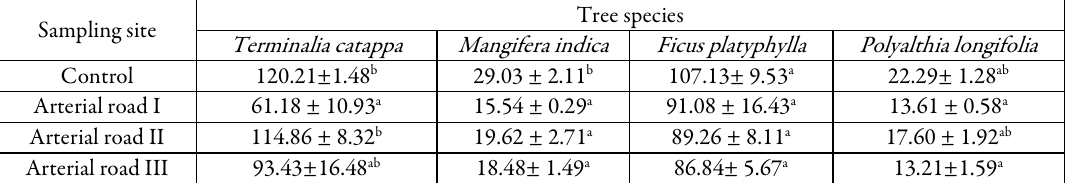
Table 4. Effect of vehicular air pollution on leaf area (mm 2 ) of four street tree species in the Kumasi Metropolis Sampling